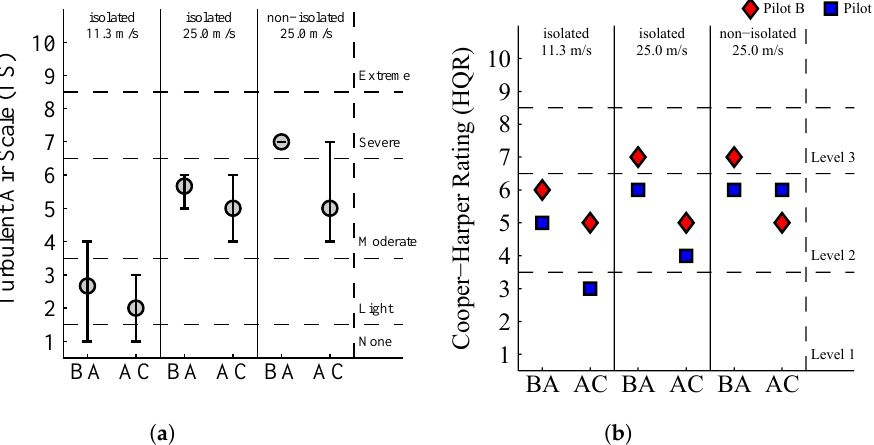
Figure 25. Subjective pilot assessment of the hover task at different positions (BA—helicopter with bare-airframe response type, AC—helicopter with attitude-command attitude-hold response type). ( a ) Turbulent Air Scale (TS, Table A2). ( b ) Cooper–Harper Handling Qualities Rating Scale (HQR, Figure